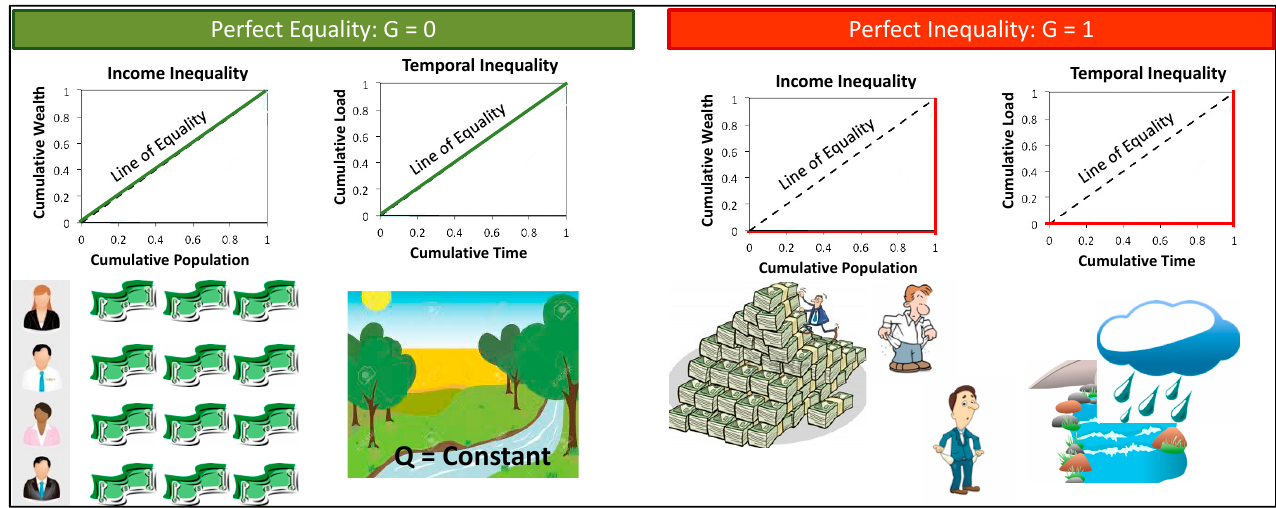
Figure 2. Visual representation of Lorenz Curves for perfect equality ( G = 0) and perfect inequality ( G = 1) scenarios in economics and their hydrologic analogues, where G is the Gini Coefficient.